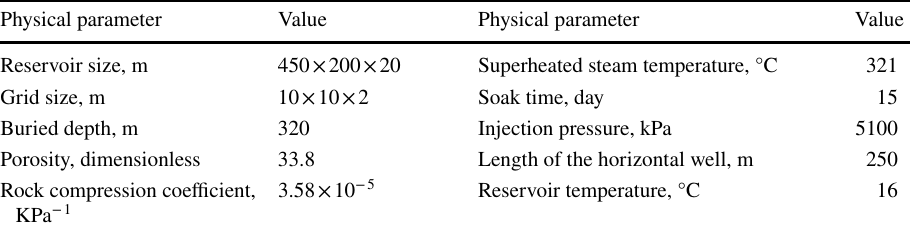
Fig. 1 The I-J and I-K profiles of the numerical model Table 1 Basic parameters of the numerical model